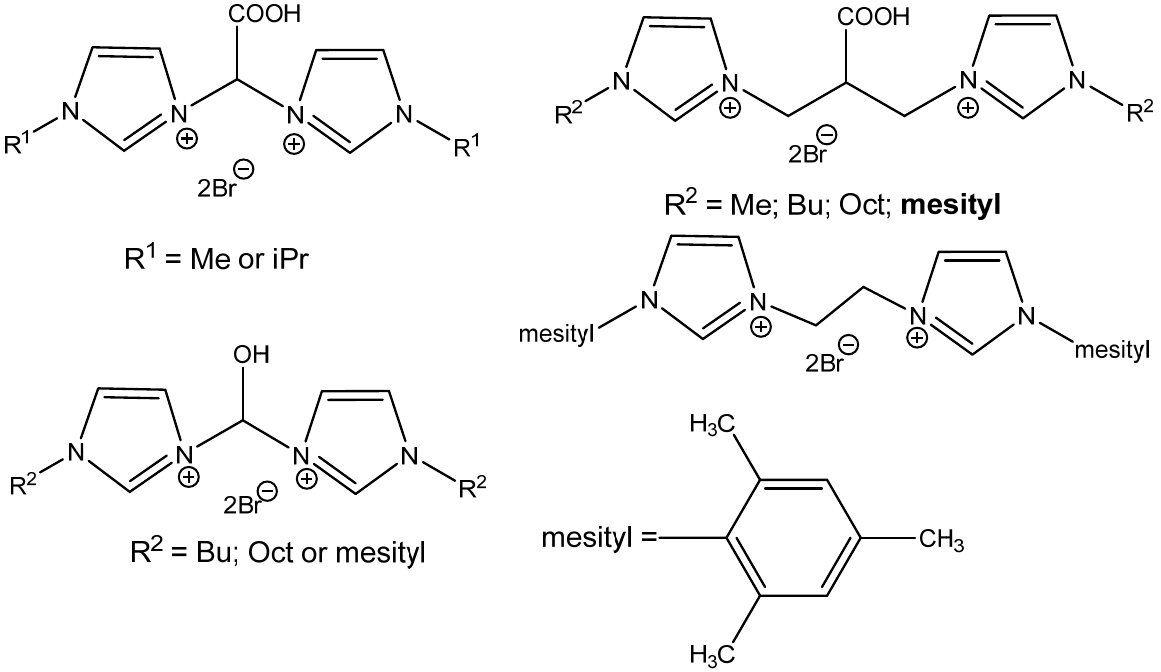
Figure 15. Multifunctional bisimidazolium bromides tested for carbonation of epoxides [99].